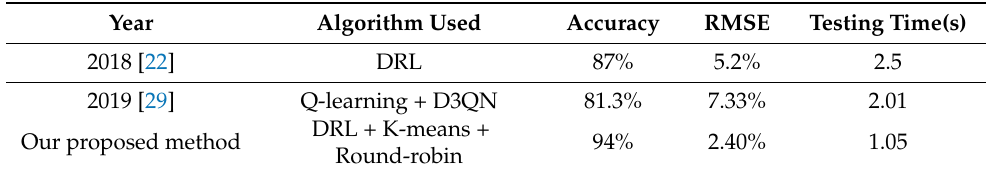
Table 7. Comparison of our proposed system with previous